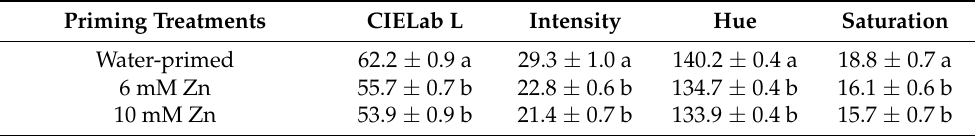
Table 2. Characteristic color parameters: CIELab L, intensity, hue, and saturation of DTZ-stained spinach seeds after water-, 6 mM, and 10 mM Zn-priming. Values represent the mean and standard error (SE) of four replicates. Significant differences between the means were calculated between seed priming treatments at p < 0.05 and marked with different letters. Priming Treatments CIELab